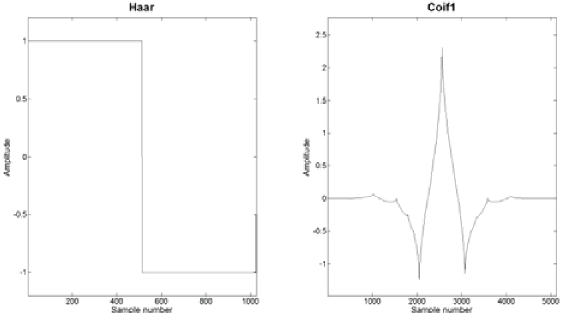
Fig. 9. Symlet 2 and 4 mother